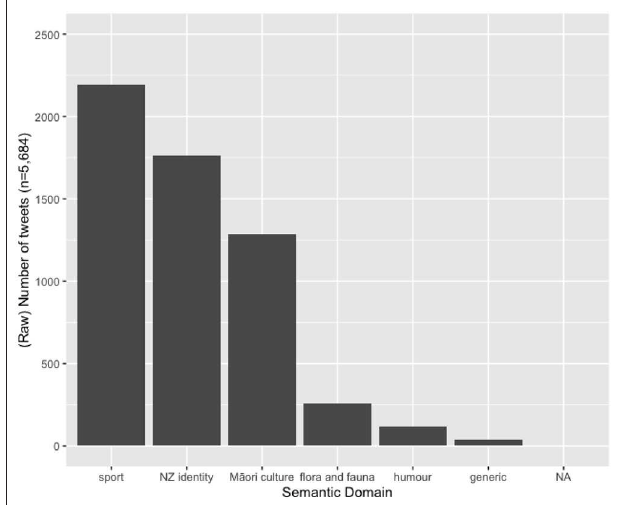
FIGURE 3 | Distribution across various semantic domains in the hybrid hashtag set.